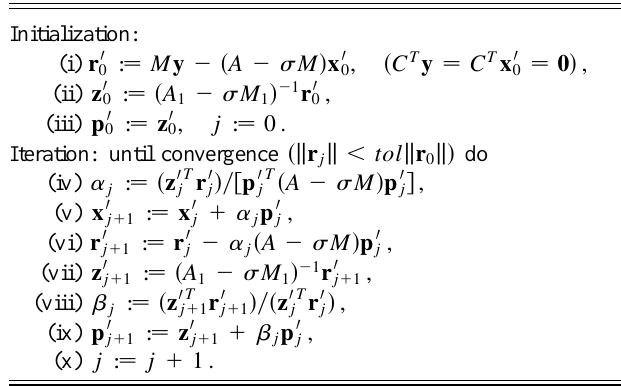
Algorithm 2. Preconditioned conjugate gradient method for the augmented linear system.